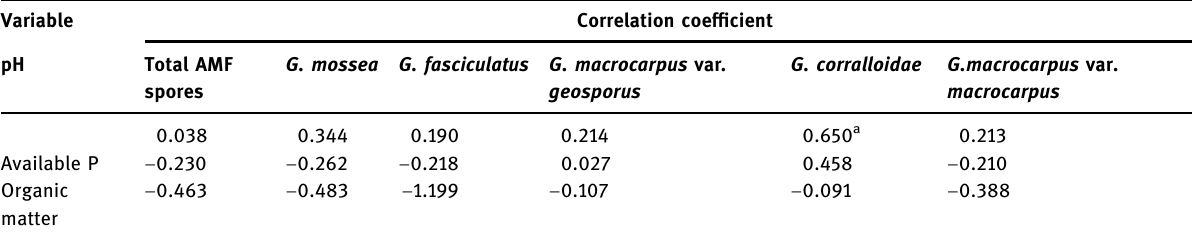
Table 8: Correlation of some soil variables with total number of AMF spores and predominant AMF spores extracted from soils of studied legume